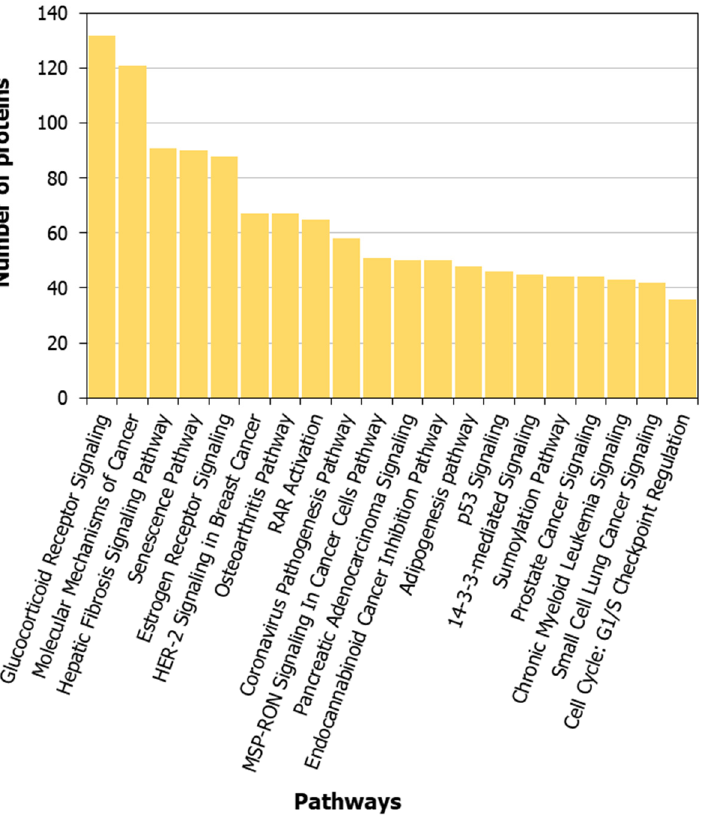
Figure 3. Pathways associated with the hypoplastic left heart syndrome (HLHS) interactome: The number of proteins from the HLHS interactome that are involved in the top 30 pathways most significantly associated with the interactome are